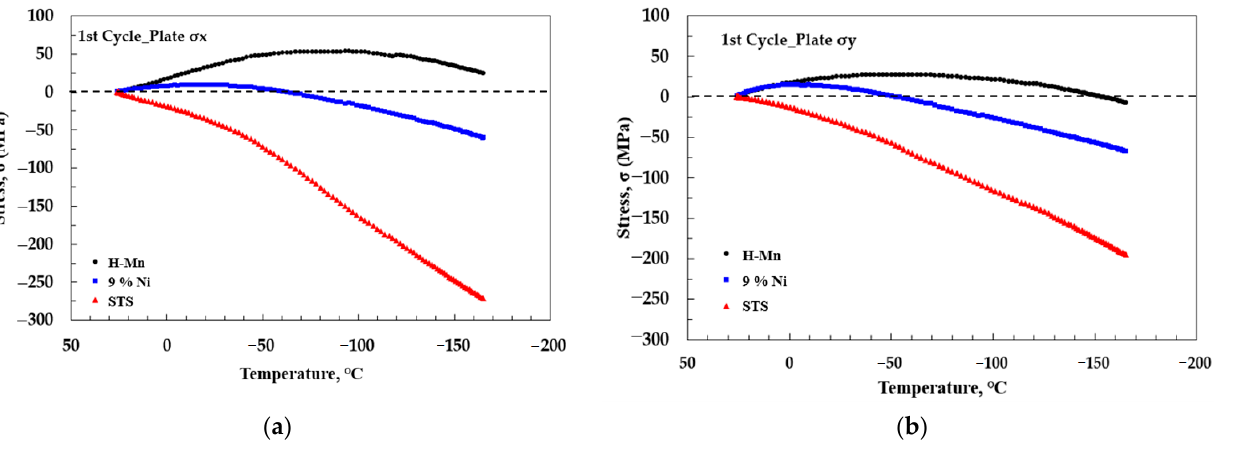
Figure 5. FE-analysis model and boundary conditions.